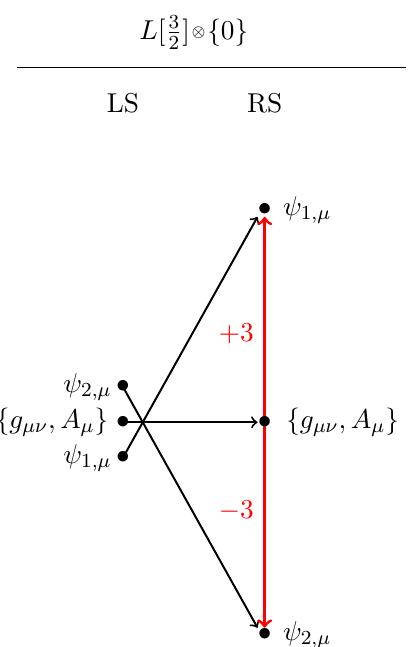
Figure 4 . Shift patterns of the conformal dimensions within L [ 3 right-squashed S 7 . Here, g µν is a graviton, A µ a vector and ψ µ a gravitino.